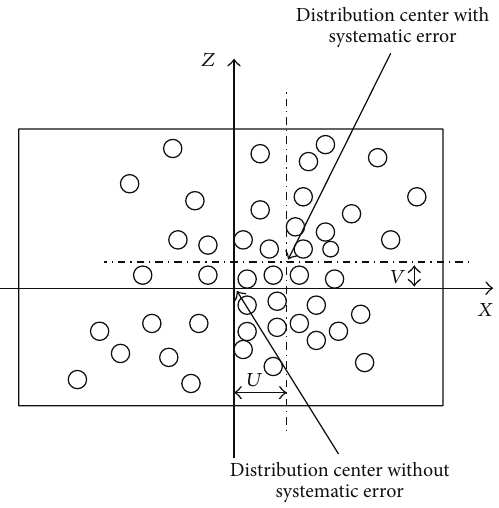
Figure 3: Distribution of the impact points.